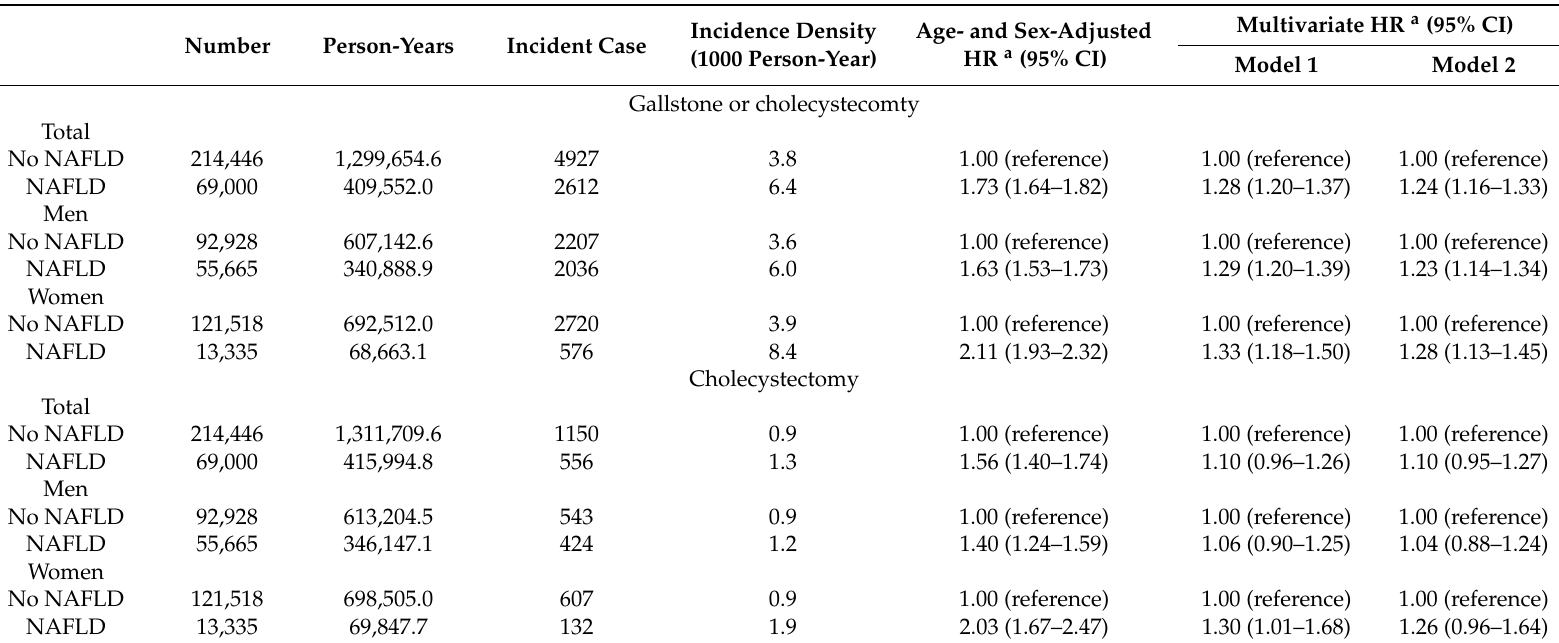
Table A3. The associations between nonalcoholic fatty liver disease (NAFLD) and the development of gallstones or cholecystectomy ( n =